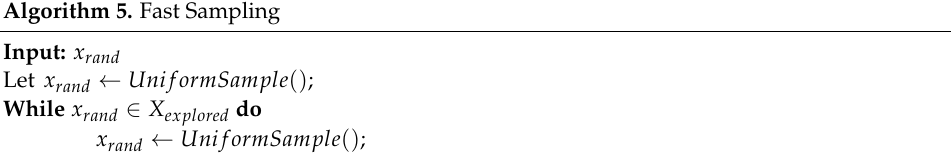
Figure 3. Schematic illustration of the Fast-Sampling sampling strategy. The red circle is the explored area. Since the first sampling point 𝑥 (cid:3045)(cid:3028)(cid:3041)(cid:3031)(cid:2869) falls in the explored area, it is regarded as an invalid sampling. After re-sampling, the second sampling point 𝑥 (cid:3045)(cid:3028)(cid:3041)(cid:3031)(cid:2870) is obtained. 𝑥 (cid:3045)(cid:3028)(cid:3041)(cid:3031)(cid:2870) bootstrap tree expansion to obtain 𝑥 (cid:3041)(cid:3032)(cid:3050) , thus avoiding invalid expansion.